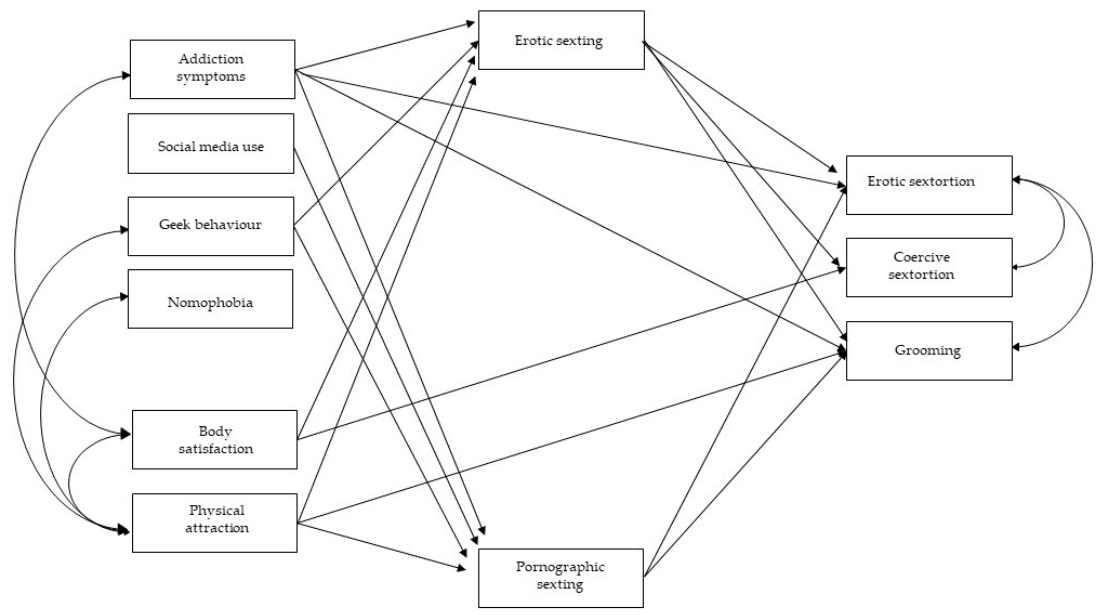
Figure 1. Tested structural equation model with partial mediation: interplay between internet and social networking addiction, body self-esteem and sexual online victimization mediated by sexting. Note . Continuous pathways are significant at p < 0.01. The relationships of the factors with their indicators have not been drawn for simplicity; non-significant pathways were not included.